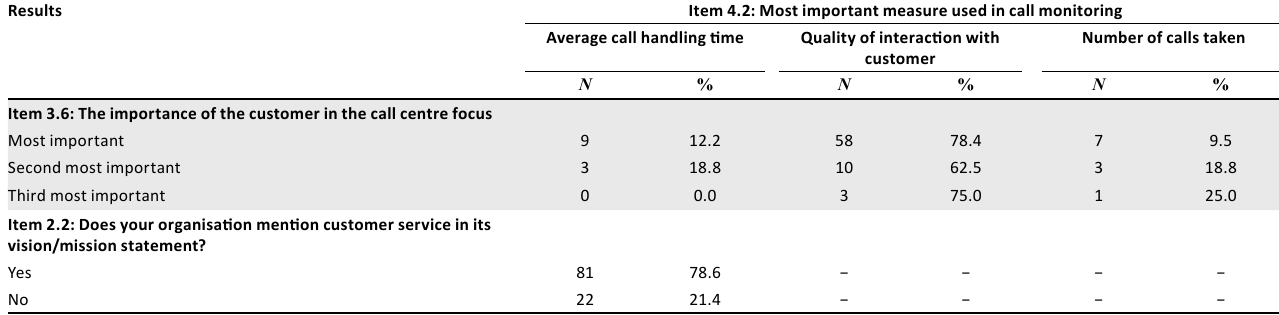
TABLE 7: Cross tabulation of the measures used in call monitoring and the importance of the customer in the call centre